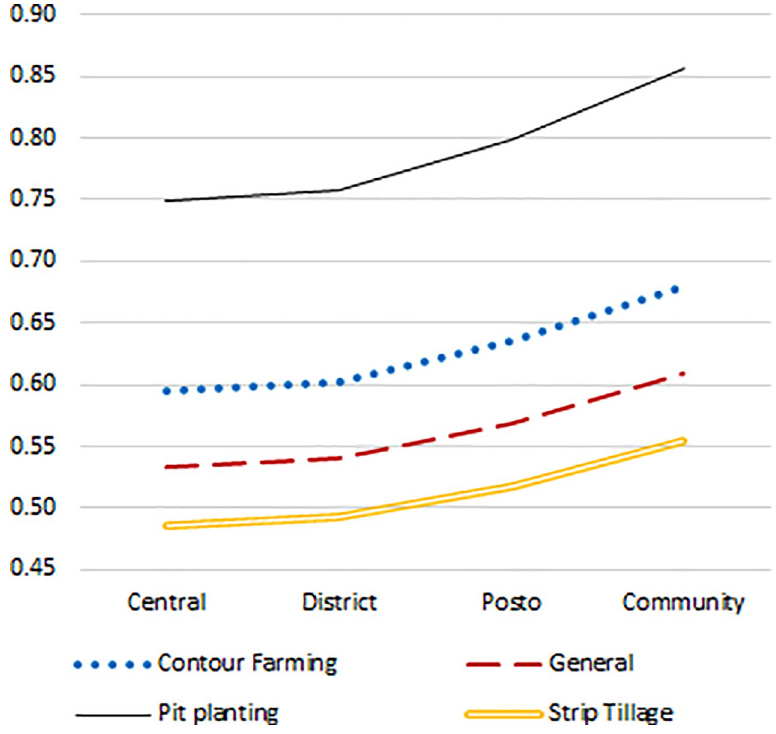
Fig 1. CGAAS: CERs of the gendered treatment as share of CERs of the general treatment. Notes: CGAAS = community-based gendered agricultural advisory services; CER = cost-effectiveness ratios. Underlying CERs pertain to cost-effectiveness of the programme in increasing knowledge about different sustainable land management (SLM) techniques: contour farming, pit planting, strip tillage, and general SLM knowledge. CERs are based on costs and impact by the time of the endline